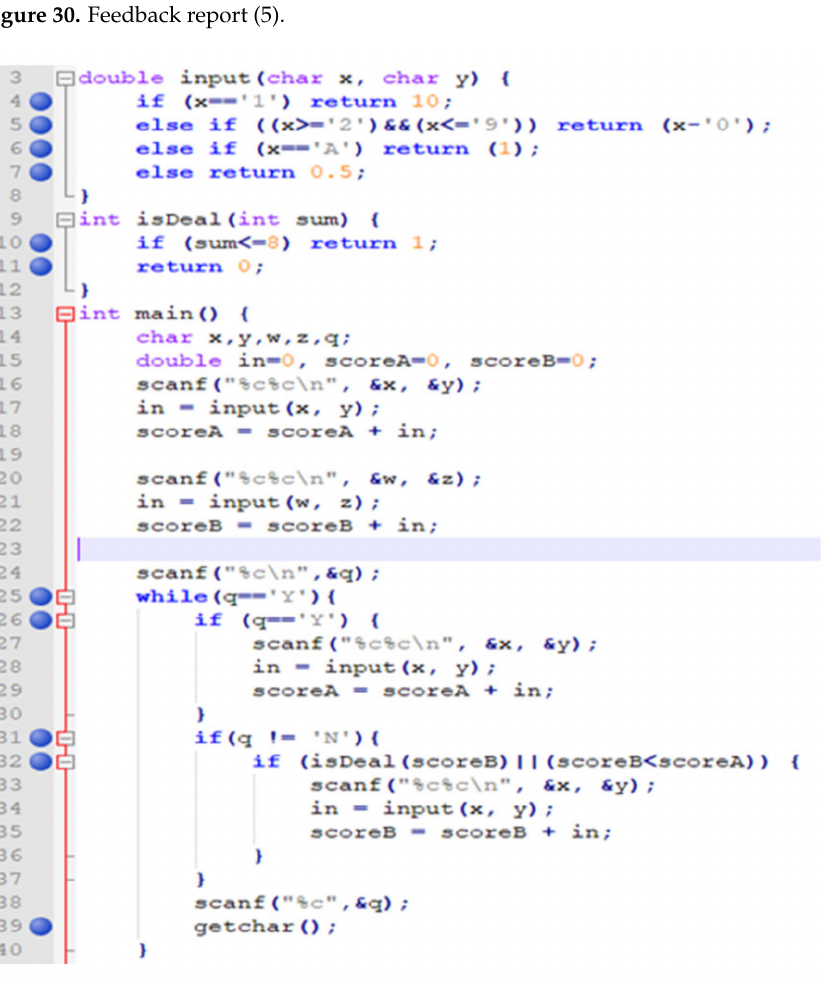
Figure 31. Example program